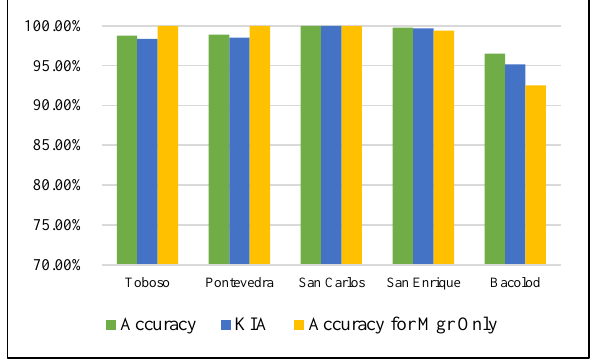
Figure 9. Shows graph of mangrove overall